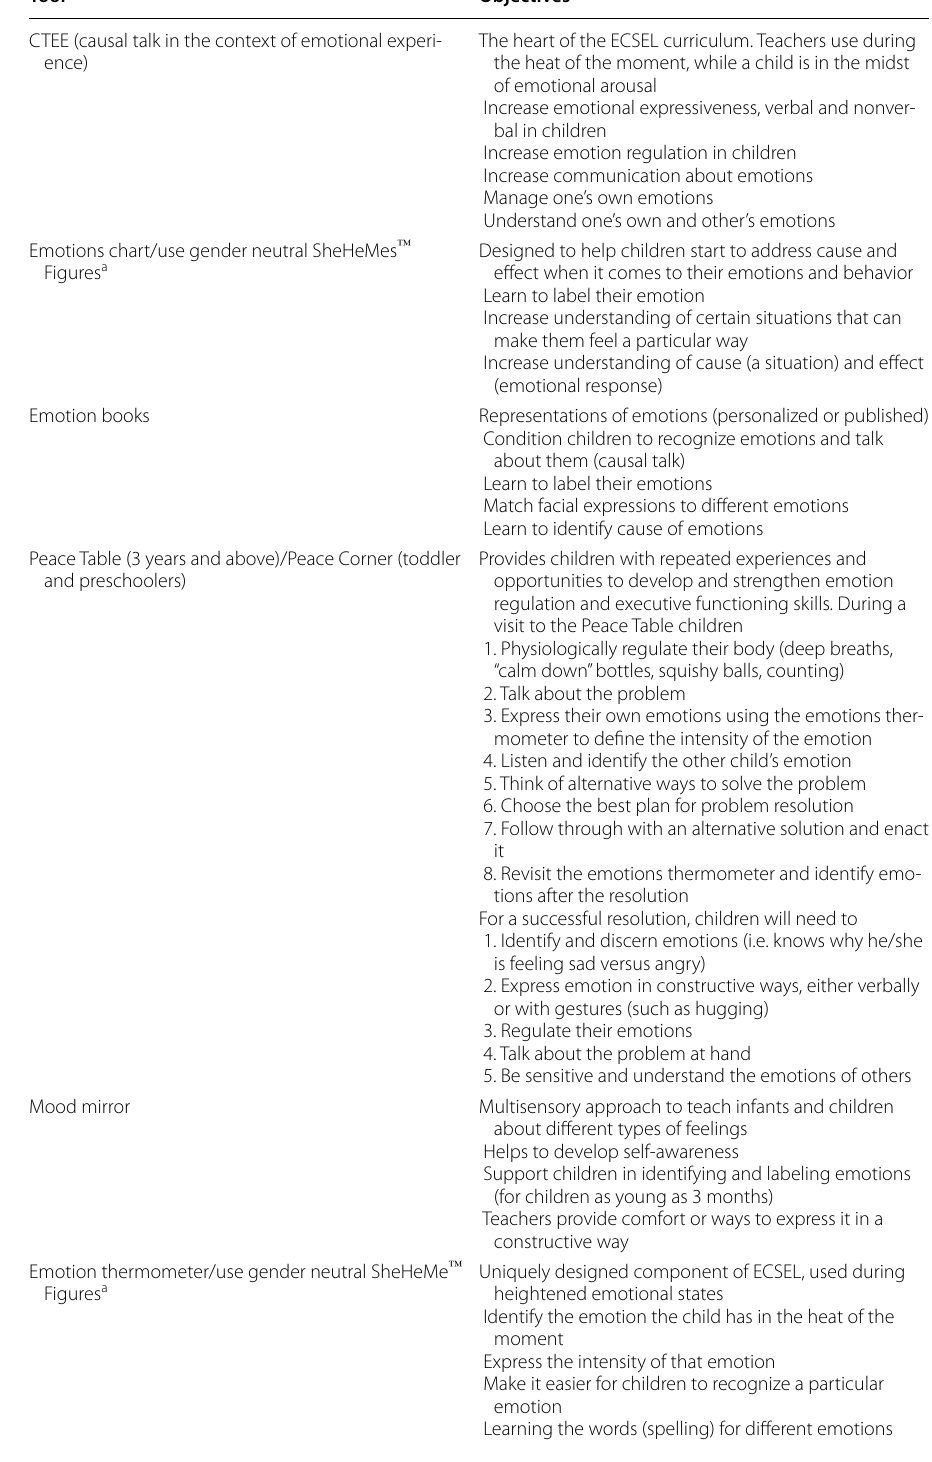
Table 3 Content and objectives of the emotional cognitive social early learning